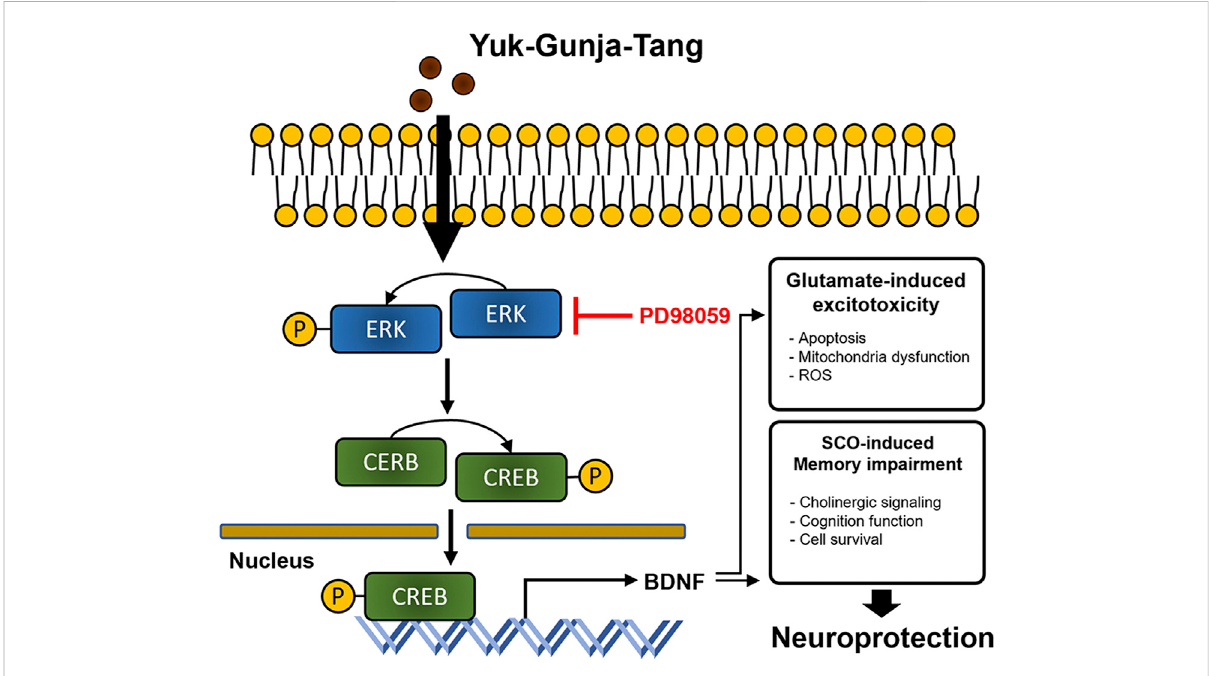
FIGURE 9 Diagram showing a hypothesized mechanism by Yuk-Gunja-Tang is effective in the treatment of Alzheimer ’ sdisease. ERK: extracellular signal- regulated kinase, CREB: cAMP response element binding protein, BDNF: brain derived neurotrophic factor, ROS: reactive oxygen species, SCO: